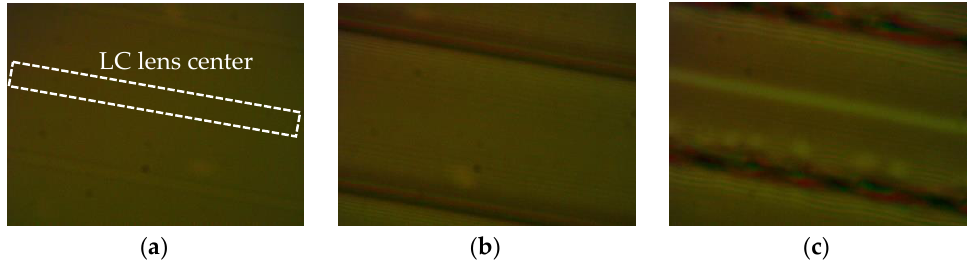
Figure 7. Interference fringes of the cylindrical LC lens array with ( a ) 0 V, ( b ) 5.4 V, and ( c ) 8 V operating voltages.